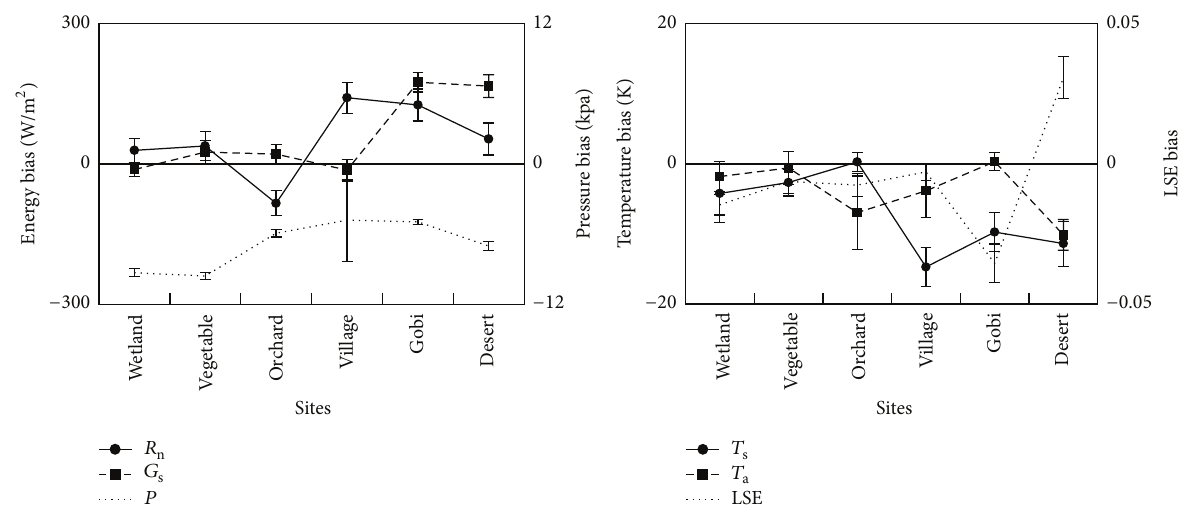
Figure 7: Average (line) and standard deviation (bar) of input parameter errors at 6 sites, including net radiation ( 𝑅 land surface temperature ( 𝑇 s ), near-surface air temperature ( 𝑇 a ), land surface emissivity (LSE), and near-surface pressure ( 𝑃 ).